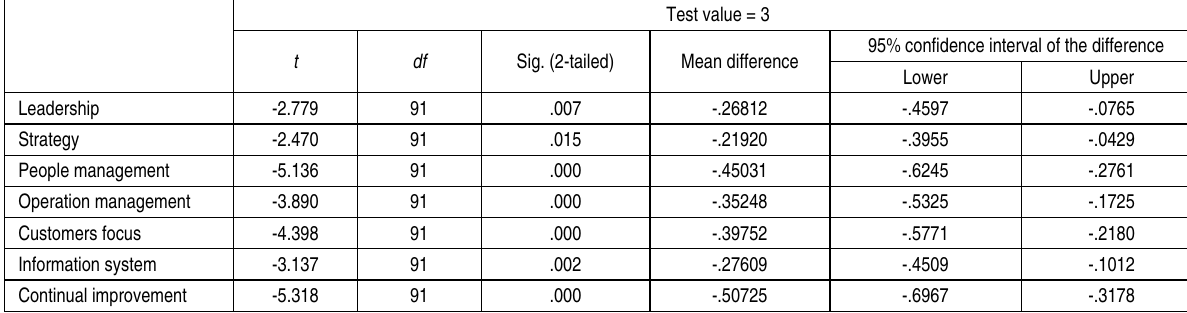
Table 2. One-sample test of independent variables